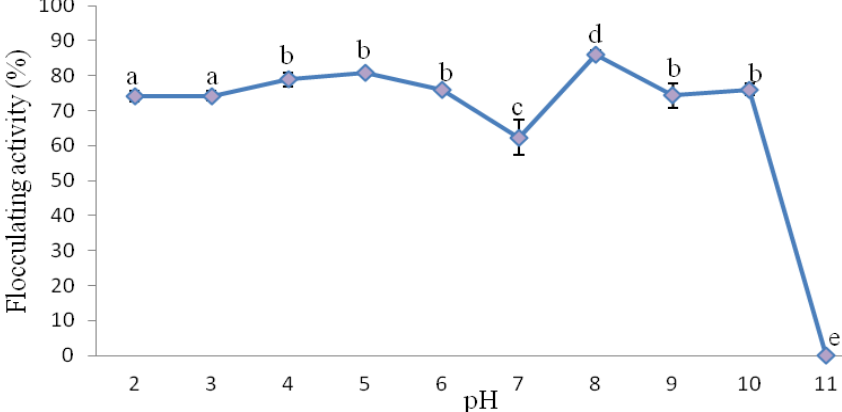
Figure 4. Effect of pH on the flocculating activity of the bioflocculant produced by a consortium ( Halomonas sp. Okoh and Micrococcus sp. Leo). Flocculating activities with different letters are significantly different ( p < 0.05) from each